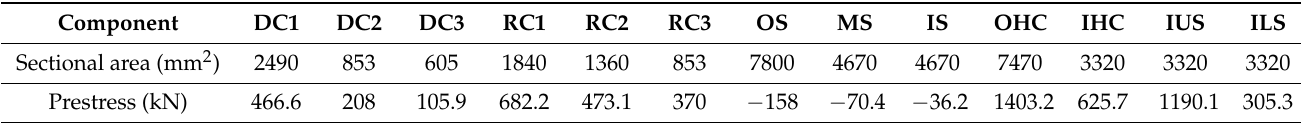
Figure 1. Investigated cable dome structure. ( a ) Structural model, ( b ) Structural plan, ( c ) Structural profile and size. Table 1. Sectional area and initial prestress of different elements.